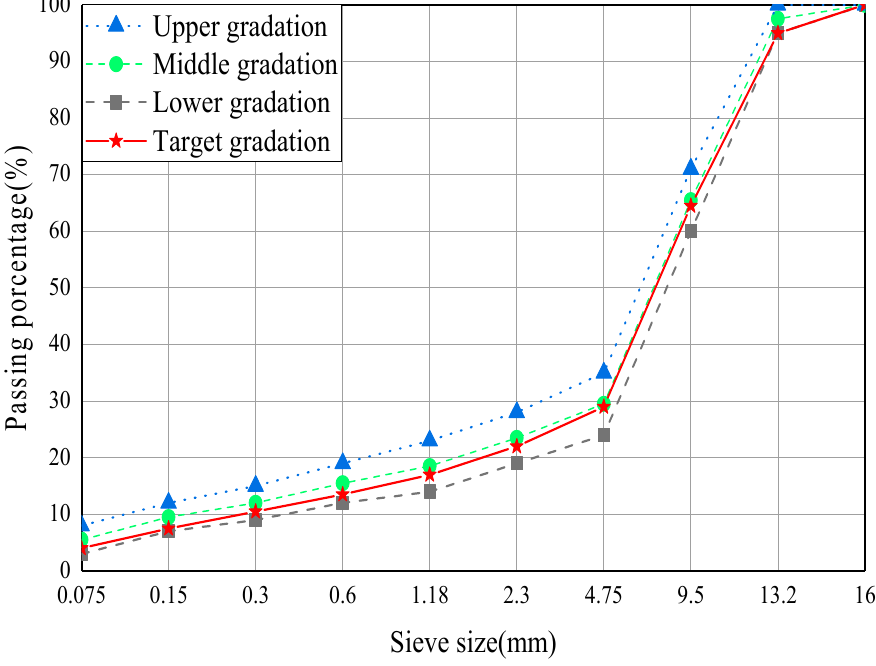
Figure 3. Gradation of the ARAC-13 rubber asphalt mixture.